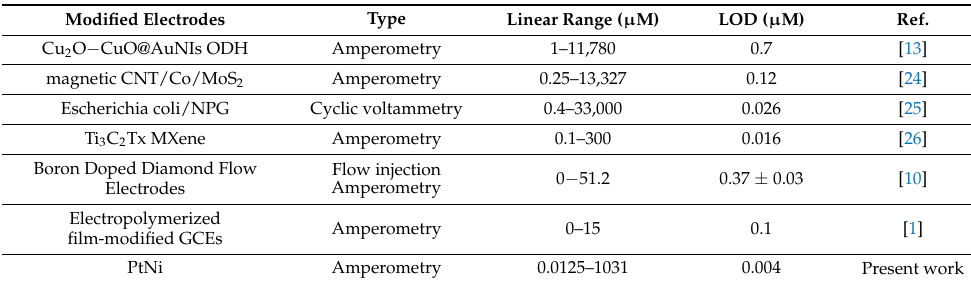
Figure 6. ( a ) Amperometry (i-t) response of various concentrations of sulfide (0.0125–1031 µ M) in 0.05 M PB (pH 7.0), ( b ) response time for steady-state current, ( c ) corresponding linear plot for I pa vs. [sulfide] ( d ) effect of interfering species Na + , K + , CO, NO, hydrogen peroxide (H 2 O 2 ), ascorbic acid (AA), L-cysteine (L-cys), uric acid (UA), dopamine (DA), and Cl − on the amperometric responses of PtNi/SPE for sulfide in 0.05 M PB (pH 7.0). Table 1. Comparison of sensor parameters (linear range and LOD) for the proposed PtNi sensor with previously reported H 2 S